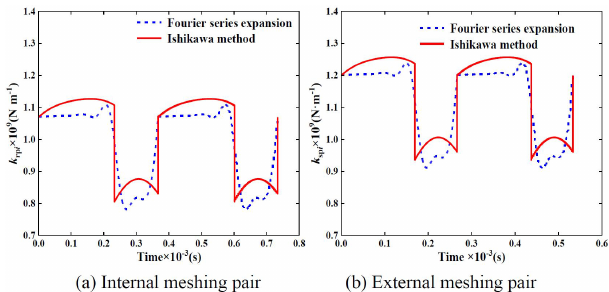
Figure 2. Time-varying meshing stiffness of the planetary